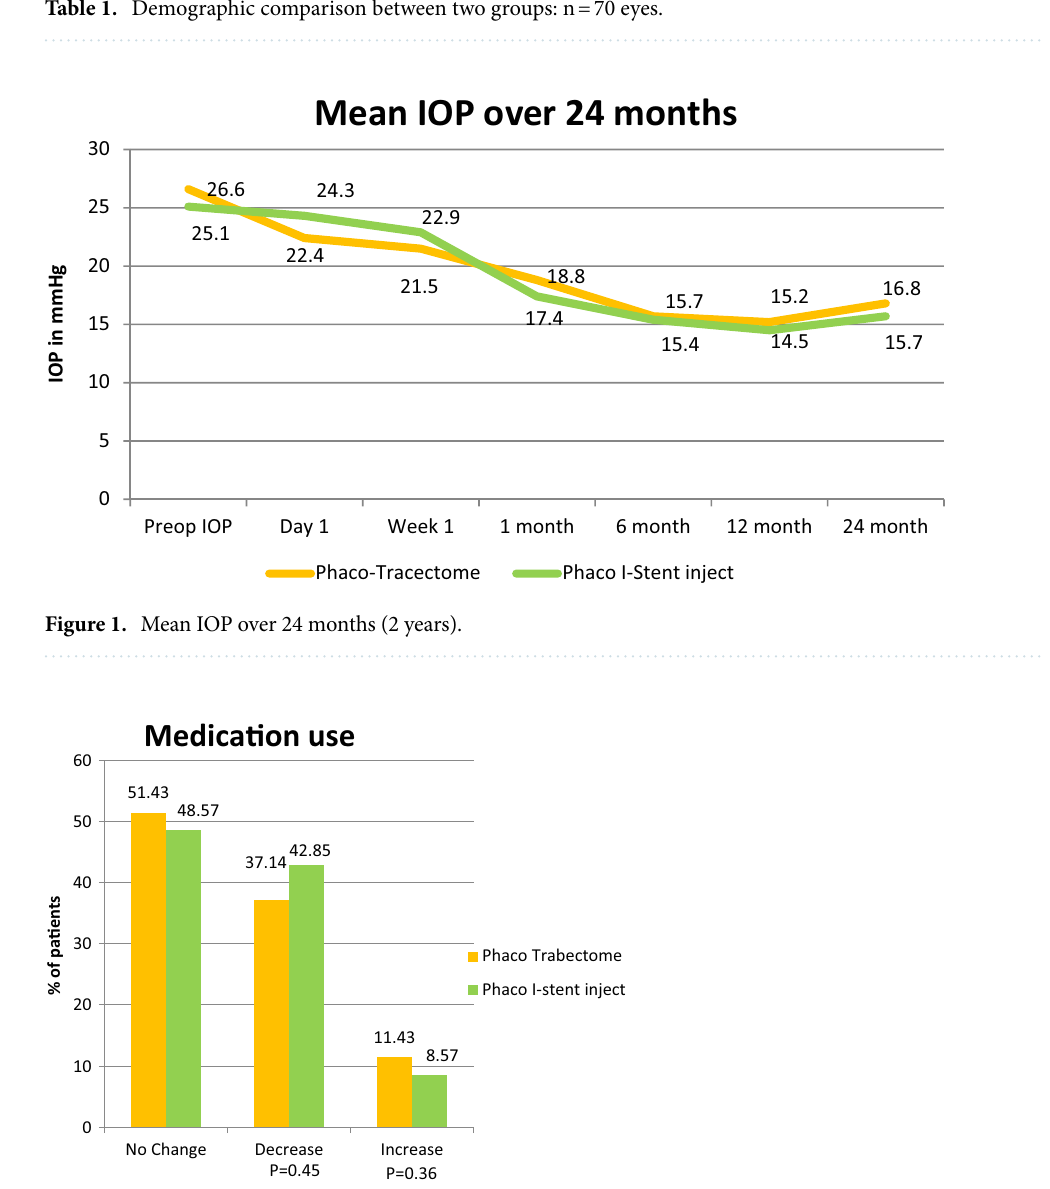
Table 1. Demographic comparison between two groups: n = 70 eyes.